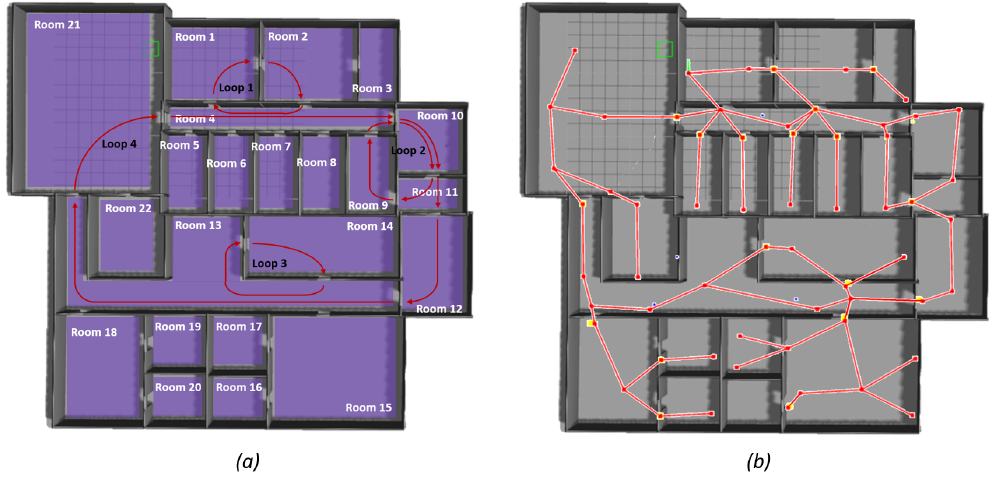
Figure 12. Results for the second big office simulated environment: ( a ) the environment and the different rooms and loops are indicated; and ( b ) the resulting topological map. The topological map is layered on top of the simulated environment in order to facilitate reader’s